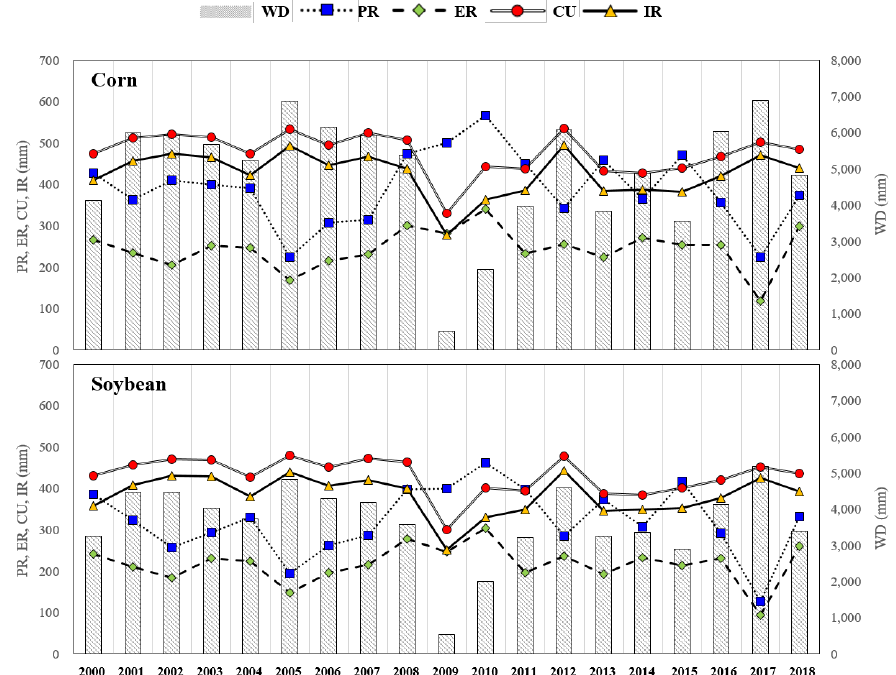
Figure 3. Results of annual water balance results (precipitation, consumptive use, effective rainfall, irrigation requirement, and water deficit) for corn and soybean in Illinois, USA.